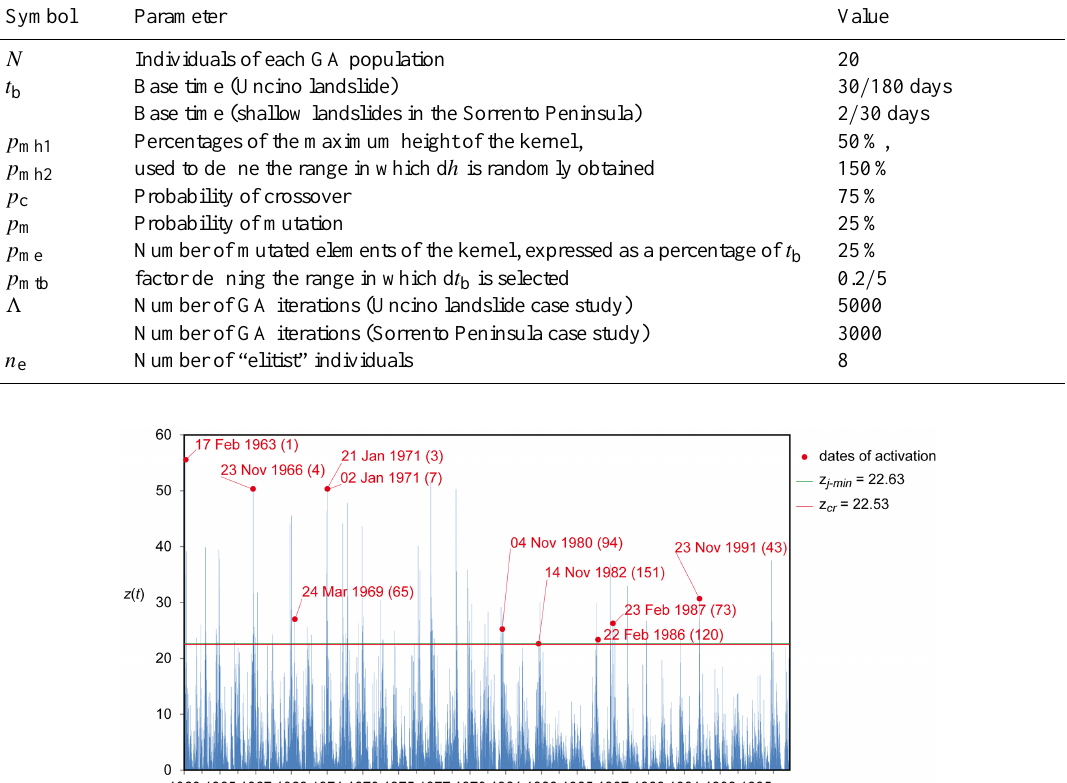
Figure 11. Sorrento Peninsula case study. Mobility function, z(t), of the average kernel. The red line ( z cr = 22.53) shows the maximum value of the mobility function (critical condition) that is unrelated to known landslide activations. The green line ( z j − min = 22.63) – almost overlapping with the red line in this case – shows the minimum value of the mobility function related to known landslide activations. When the mobility function exceeds the threshold marked by the red line, landslide activation may occur. The red dots represent the maxima of the mobility function corresponding to the dates of landslide activation considered for calibration.